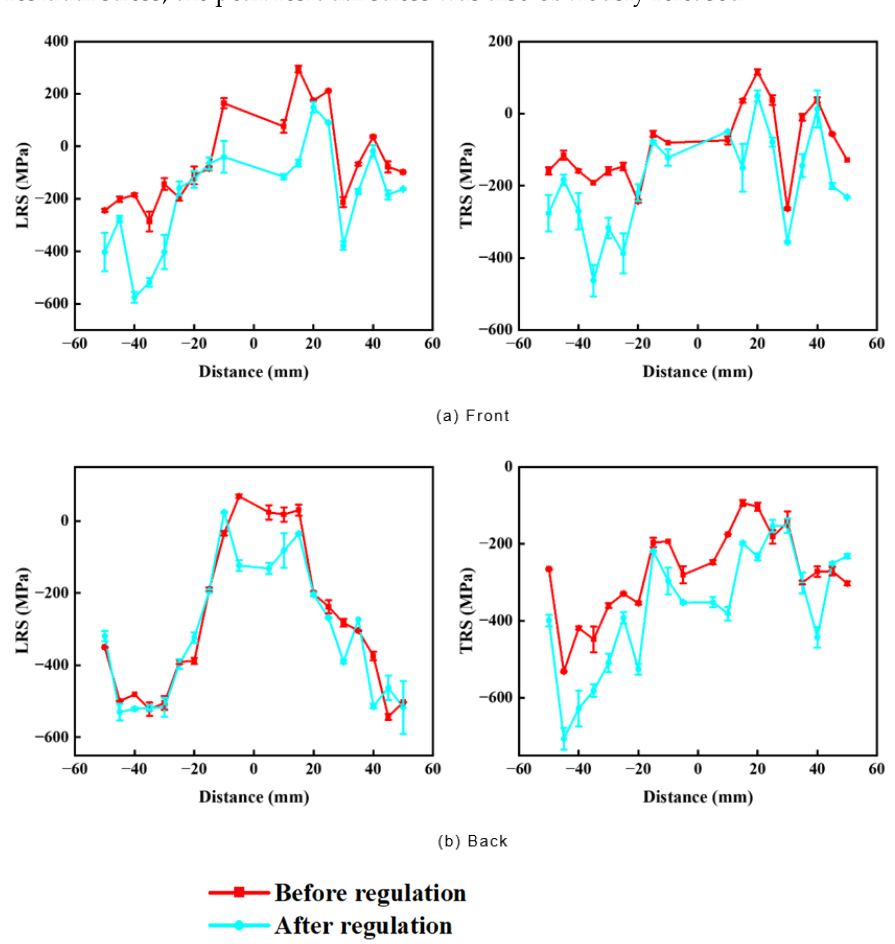
Figure 11. Residual stress distribution of #7 samples before and after treatment. ( a ) Front; ( b ) Back As can be seen in Figure 12, the comparison of longitudinal residual stress control effects of the seven groups of samples is listed. Compared to the peak residual stress re- lease amount of seven samples, the longitudinal and transverse residual stresses of sample #7 were all released, and the residual tensile stresses were almost all released. Many ex- periments have confirmed that the longitudinal and transverse residual stresses on both sides of the sample were significantly and stably relieved under this control parameter.